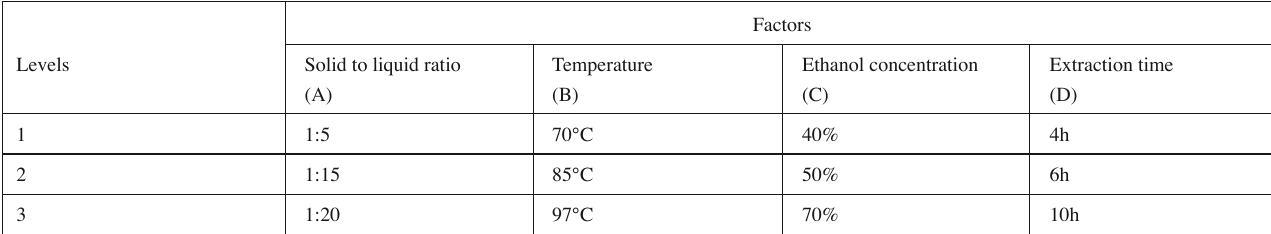
Tab. 3: Factors and levels of orthogonal experiments for C . vulgaris